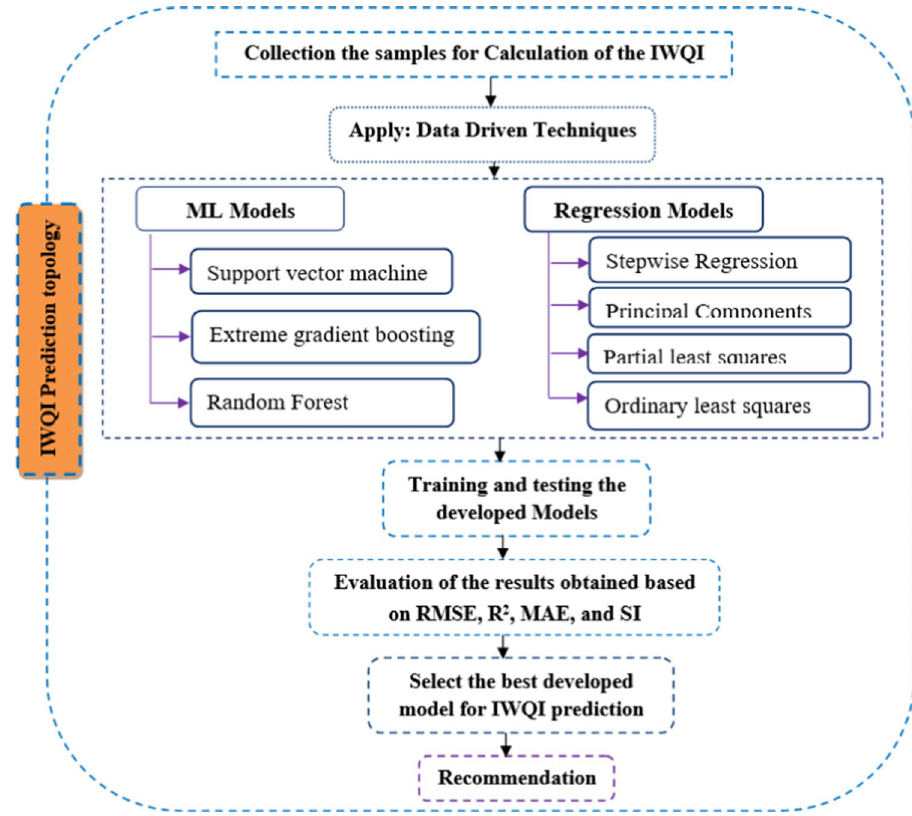
Fig. 2 Flow chart of the meth- odology of IWQI